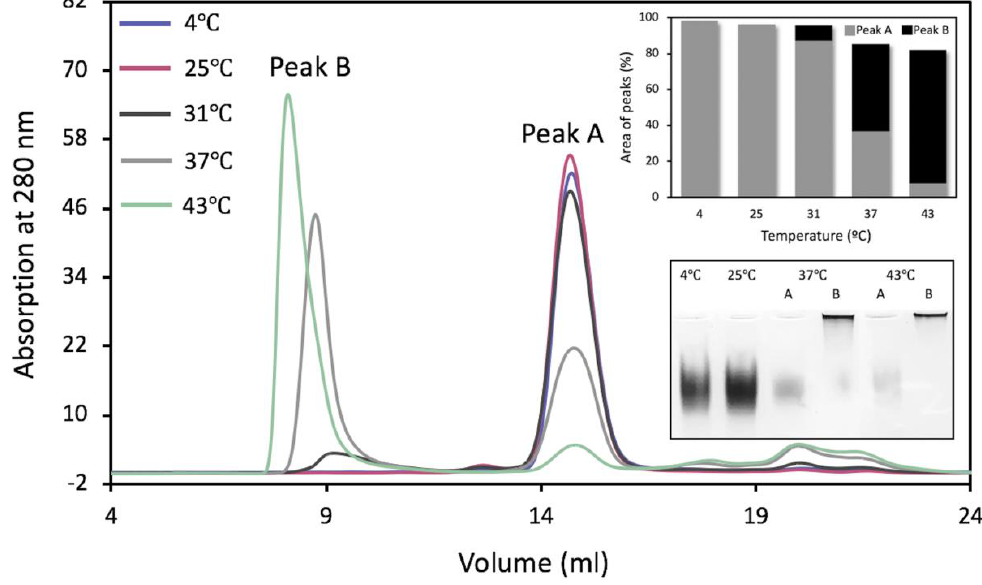
Figure 3. Gel-filtration chromatography of Tyrp1tr. The graph shows the chromatography profiles of Tyrp1tr pre-incubated for 24 h, at 4 (blue line), 25 (pink line), 31 (black line), 37 (gray line), and 43 °C (green line) and eluted from the Superdex 200 Increase GL 10 / 300 column as Peaks A and / or Peaks B. The top insert shows the % of the peak’s area calculated from the Unicorn 7.0 software (GE Healthcare Bio-Sciences, Pittsburgh, PA, USA), as well as the ratios between Peaks A (gray bars) and Peaks B (black bars). The bottom insert shows the native gel of Tyrp1tr fractions collected from Peaks A and B. From the left: fractions pulled from Peak A of Tyrp1tr pre-incubated for 24 h, at 4 °C (4 °C); fractions pulled from Peak A of Tyrp1tr pre-incubated for 24 h at 25 °C (25 °C); fractions pulled from the Peak A (37 °C, A) and Peak B (37 °C, B) of Tyrp1tr pre-incubated for 24 h at 37 °C; fractions pulled from the Peak A (43 °C, A) and Peak B (43 °C, B) of Tyrp1tr pre-incubated for 24 h, at 43 °C.